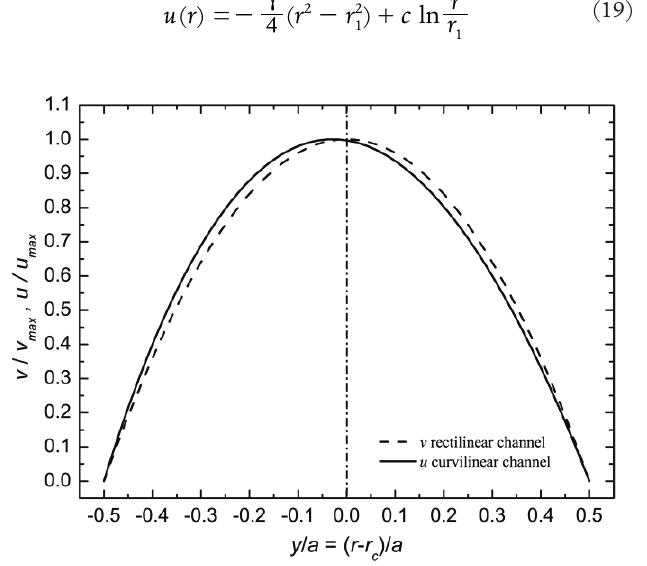
Figure 12. Comparison between the velocity as a function of the horizontal coordinate in a rectilinear channel (dashed line), and in a curvilinear channel (solid line). The vertical line indicates the center of . the channel r c